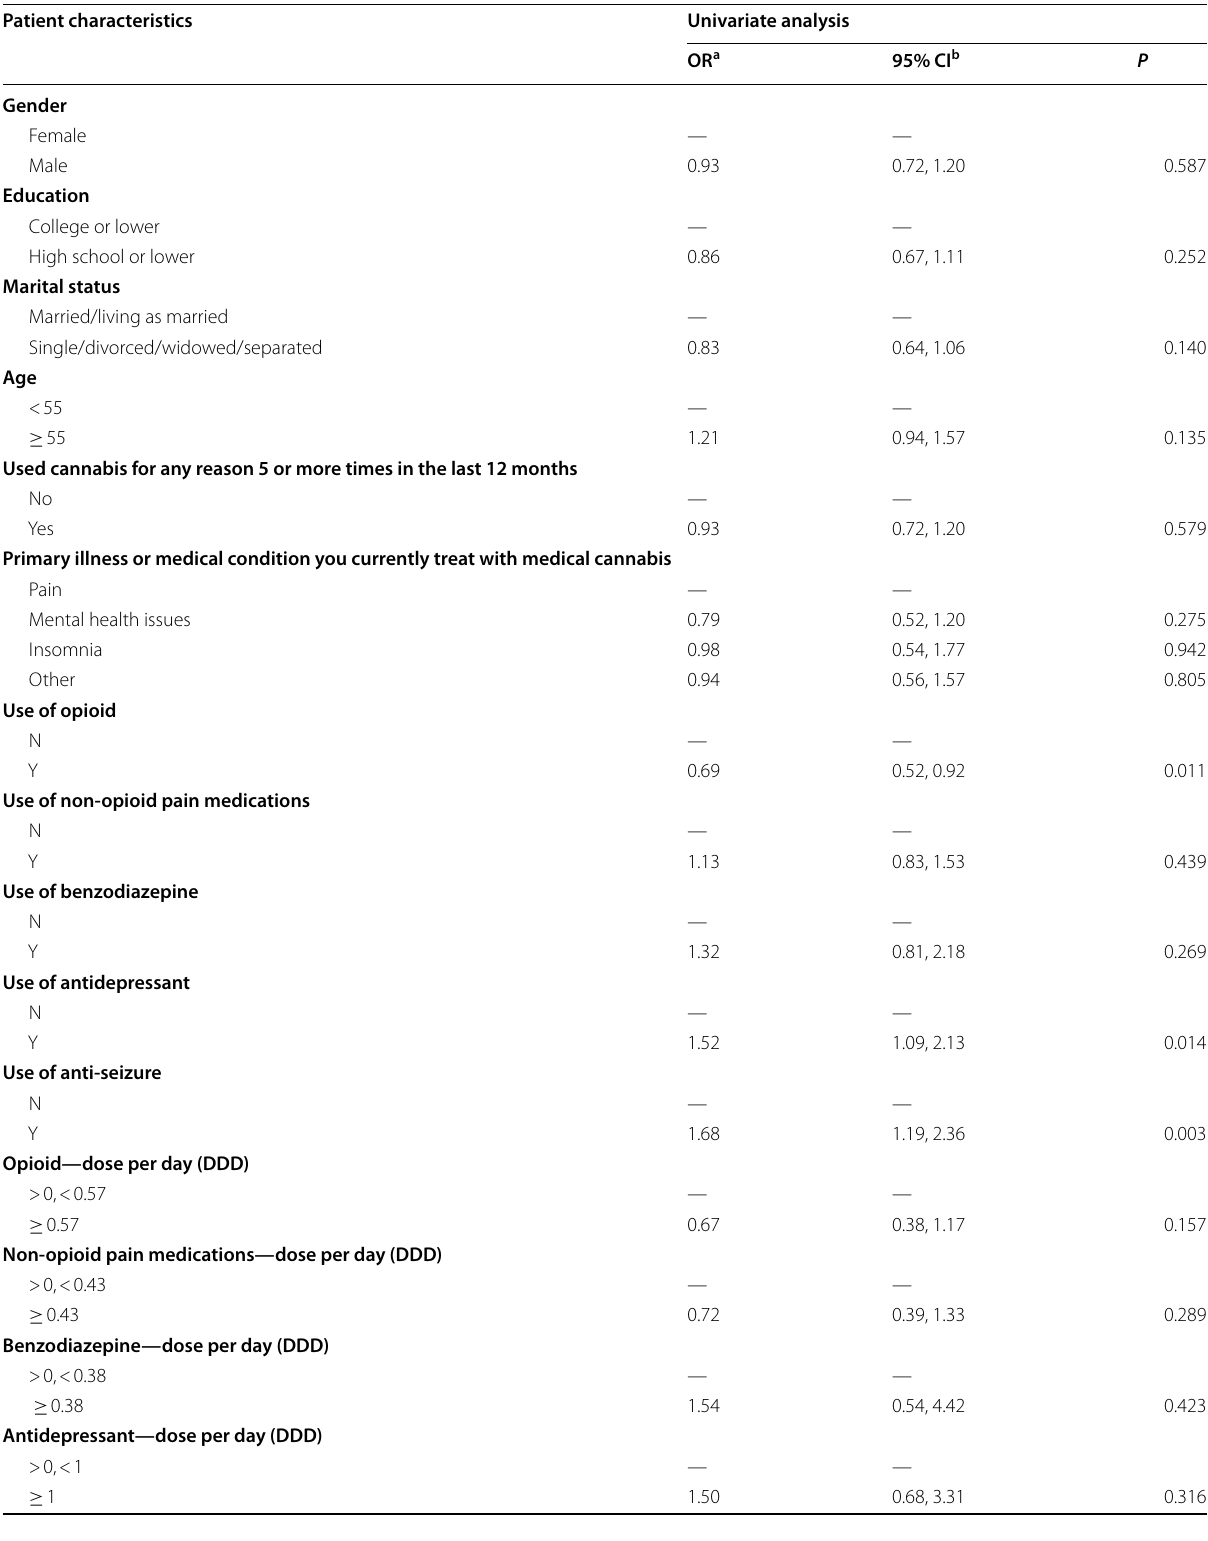
Table 4 Unadjusted odds of completing M6 in 1011 participants by baseline patient characteristics and other variables Patient